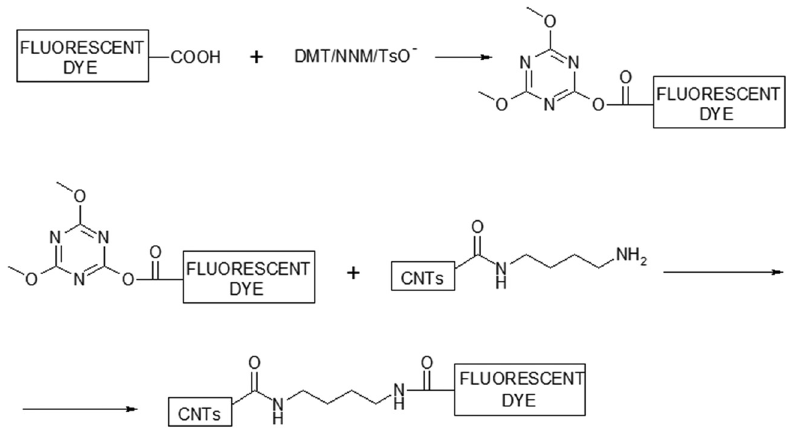
Figure 4: Synthesis of MWCNTs with fl uorescent dye.